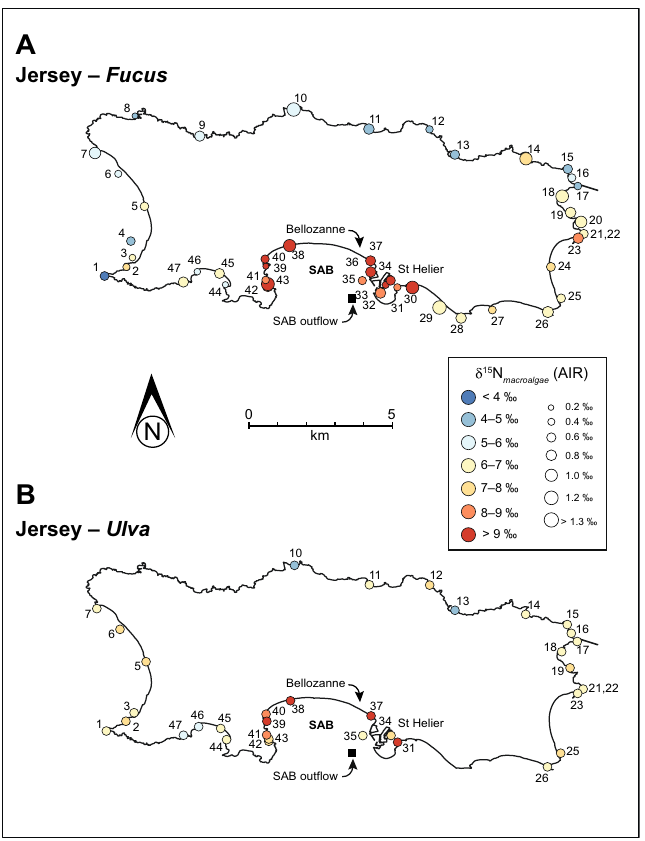
Figure 3. δ 15 N isoplot map for the macroalgae, Fucus ( A ) and Ulva ( B ) around Jersey, Channel Islands. Colour range represent distinct δ 15 N value ranges, while the size of the circle represents the standard deviation of δ 15 N from each site. Elevated macroalgae δ 15 N values are recorded for St Aubin’s Bay (Sites 30–43) and is associated to the Bellozanne STW outflow. Normal background macroalgae δ 15 N values are located on the west and north coastlines (blue circles). For abbreviations refer to Fig.